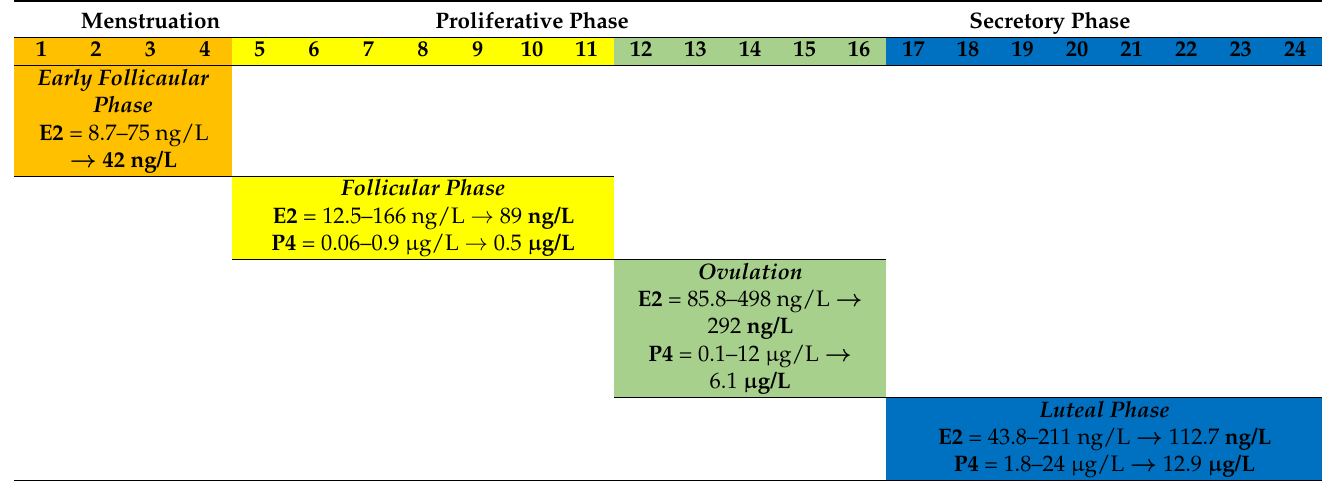
Table 3. Hormone administration mimicking the hormonal changes of a 24 day long menstrual cycle. Mean serum levels of E2 and P4 were used for treatment.